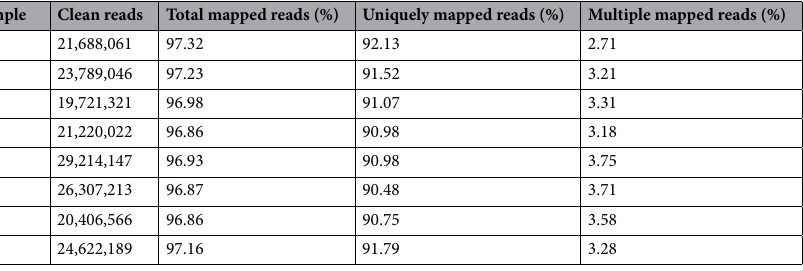
Table 3. Summary of sequencing reads alignments to the Bos taurus reference genome. H1, H2, H3, and H4 represent four samples of the highest WHC group; L1, L2, L3, and L4 represent four samples of the lowest WHC